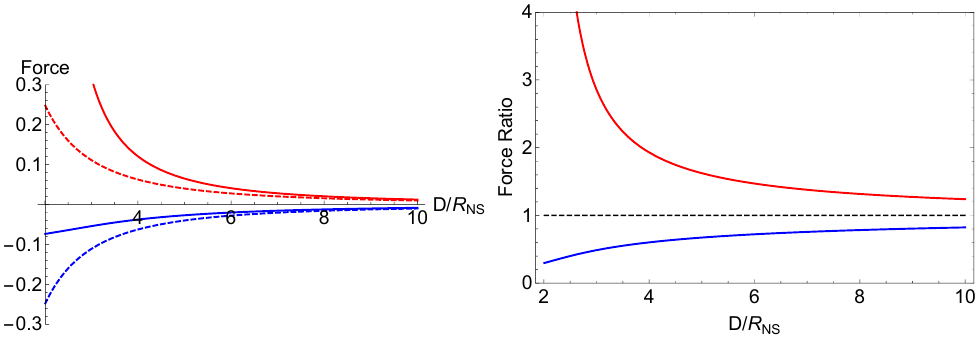
Figure 3 . (Left (cid:12)gure) The force (arbitrary units) between the two neutron stars as a function of the distance between them. The blue solid curve shows the attractive force between two neutron stars with the same axion (cid:12)eld value inside them ( (cid:18) 0 ( r ) = (cid:18) ( r )) while the red solid curve shows the repulsive force between two neutron stars with opposite axion (cid:12)eld values ( (cid:18) 0 ( r ) = (cid:0) (cid:18) ( r )). The dashed lines show the same force but with neutron stars treated as point sources. (Right (cid:12)gure) The ratios between the attractive (blue curve) and repulsive (red curve) forces mediated by the axion to the corresponding forces between point sources. At short distances, the attractive force is weaker than the forces between point sources while the repulsive force is stronger than the forces between point